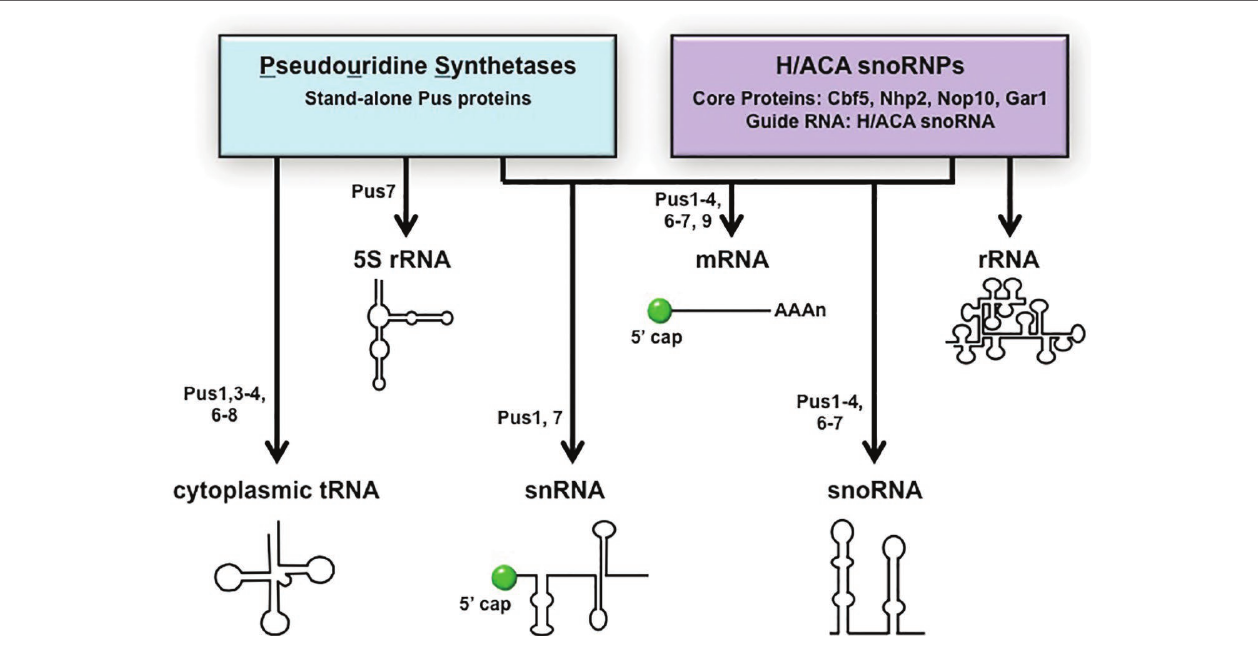
FIGURE 3 | The “tRNA” pseudouridine synthetases also modify mRNA, snRNAs, and snoRNAs. Pseudouridine modification of various RNAs is catalyzed by stand- alone proteins called pseudouridine synthetases (Pus) or RNPs containing guide RNAs called H/ACA snoRNPs. tRNAs and 5S RNA are pseudouridinylated solely by Pus proteins and rRNAs solely by H/ACA snoRNPs. Pseudouridine modifications of mRNA, snRNA, and snoRNA are catalyzed by either Pus proteins or H/ACA snoRNPs in a site-specific manner. The specific Pus proteins known to pseudouridinylate each RNA species are indicated. RNA substrates are not drawn to